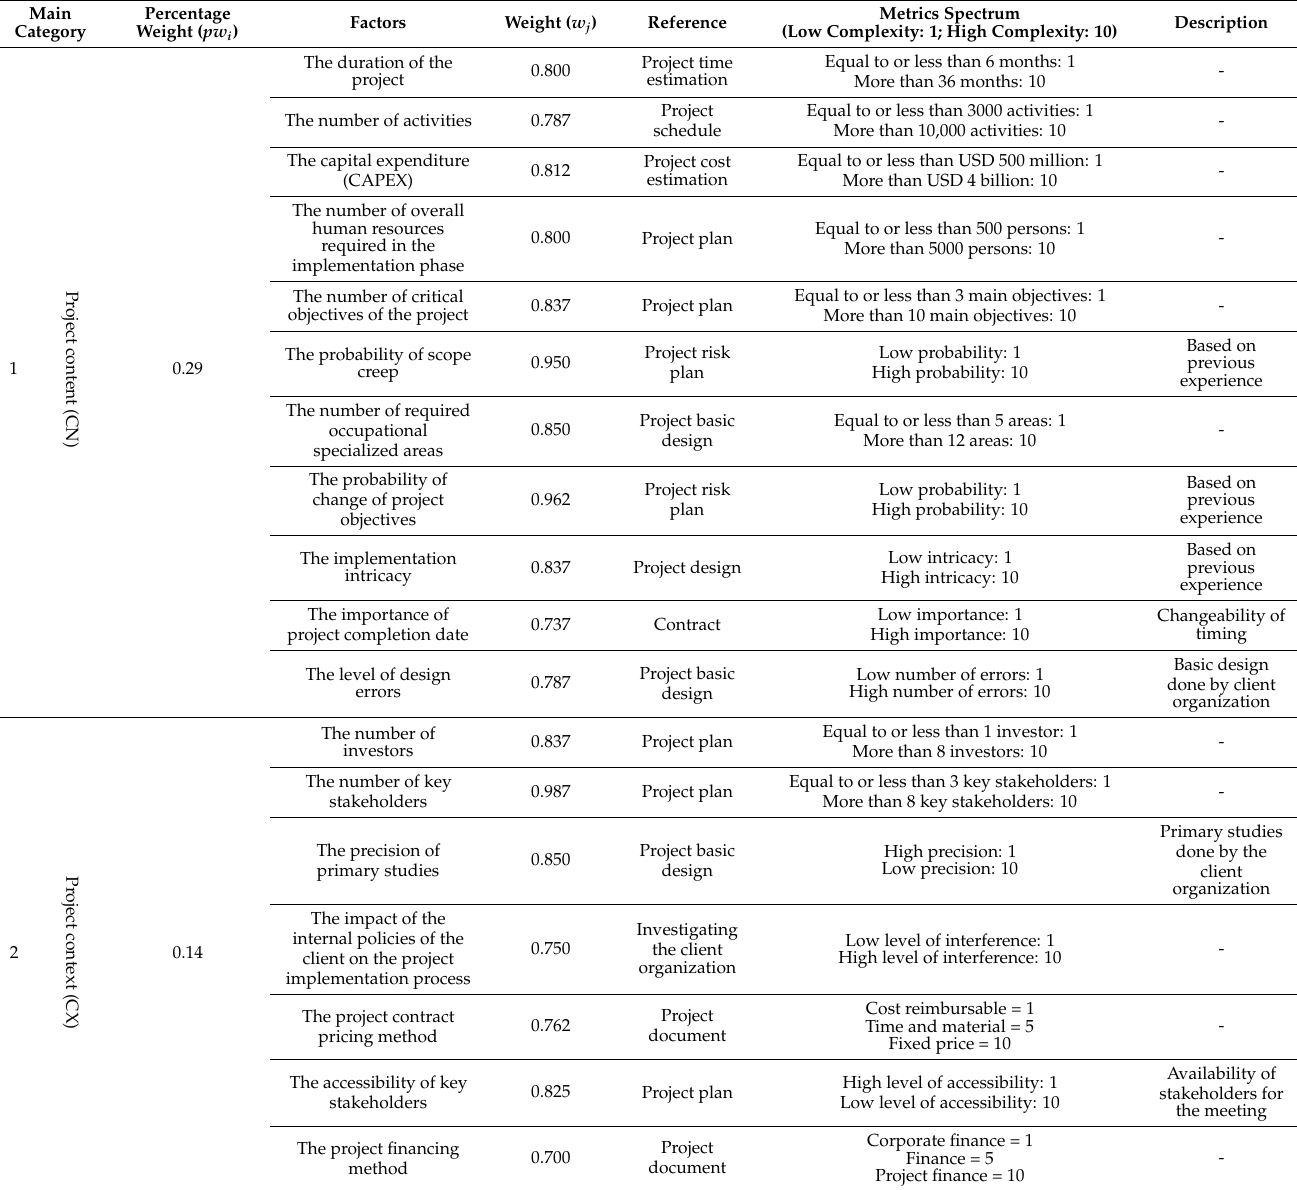
Table 6. Effective factors on the project complexity index (PCI), their weights, references, and